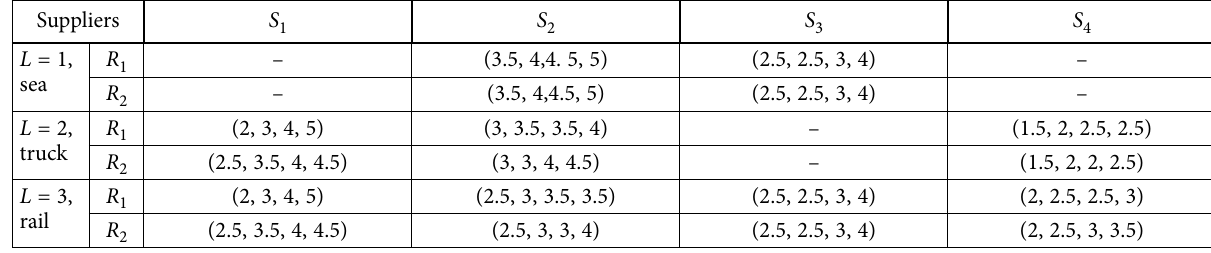
Table 5. TrFN Transfer time of transported goods from supplier to retailer (per